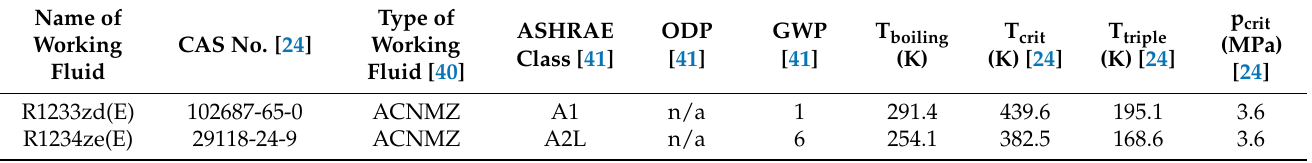
Table 6. Selected working fluids and their most important